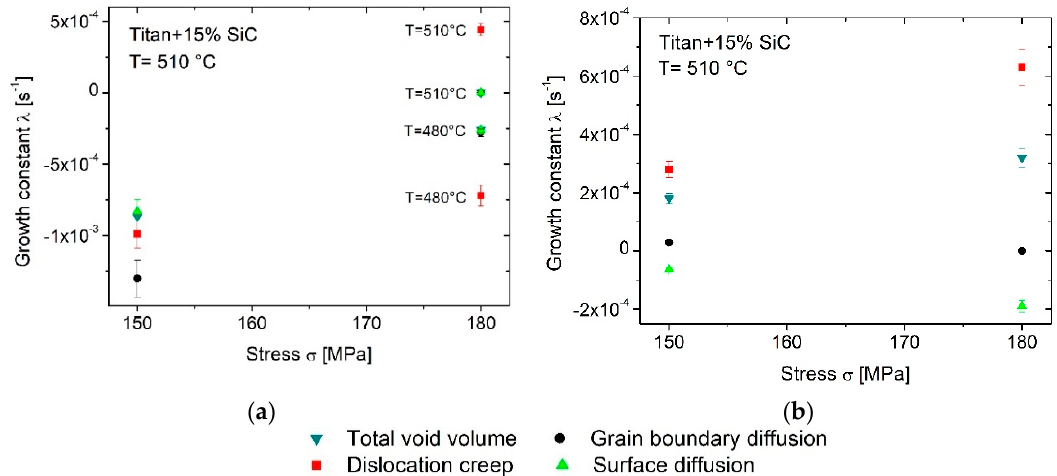
Figure 12. Ti-MMC, void growth, exponential fit: ( a ) early stage; ( b ) late stage.